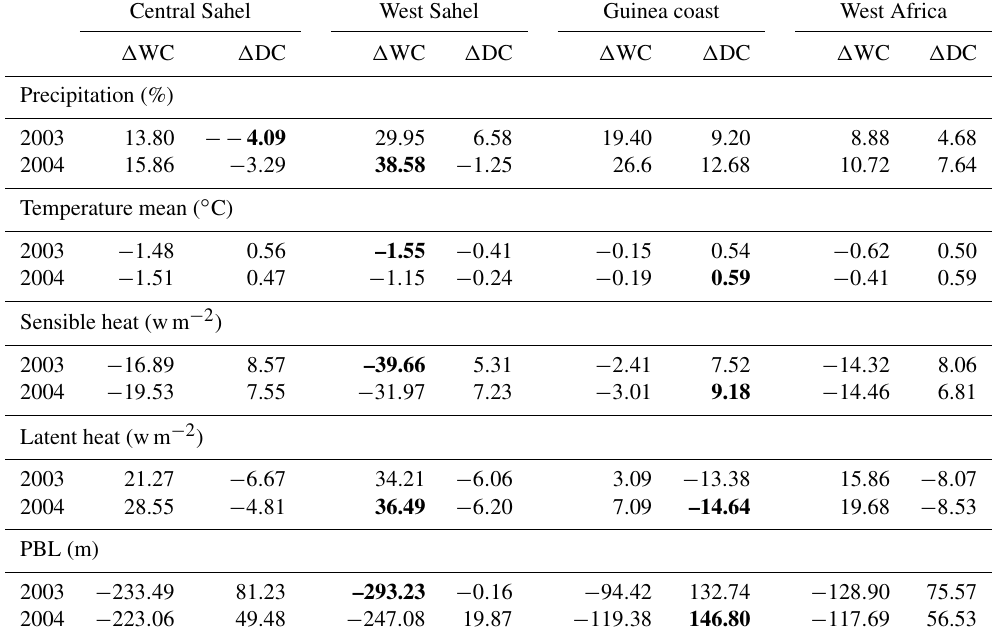
Table 2. Table summarizing the maximum values of change obtained from the PDF distribution for precipitation, temperature, sensible heat, latent heat and the PBL, calculated for the Guinea coast, Central Sahel, West Sahel and entire West Africa domains during the JJAS 2003 and JJAS 2004 periods. Values in bold indicate regions with the smallest and largest changes in maximum values for the dry and wet experiments. Central Sahel West Sahel Guinea coast West